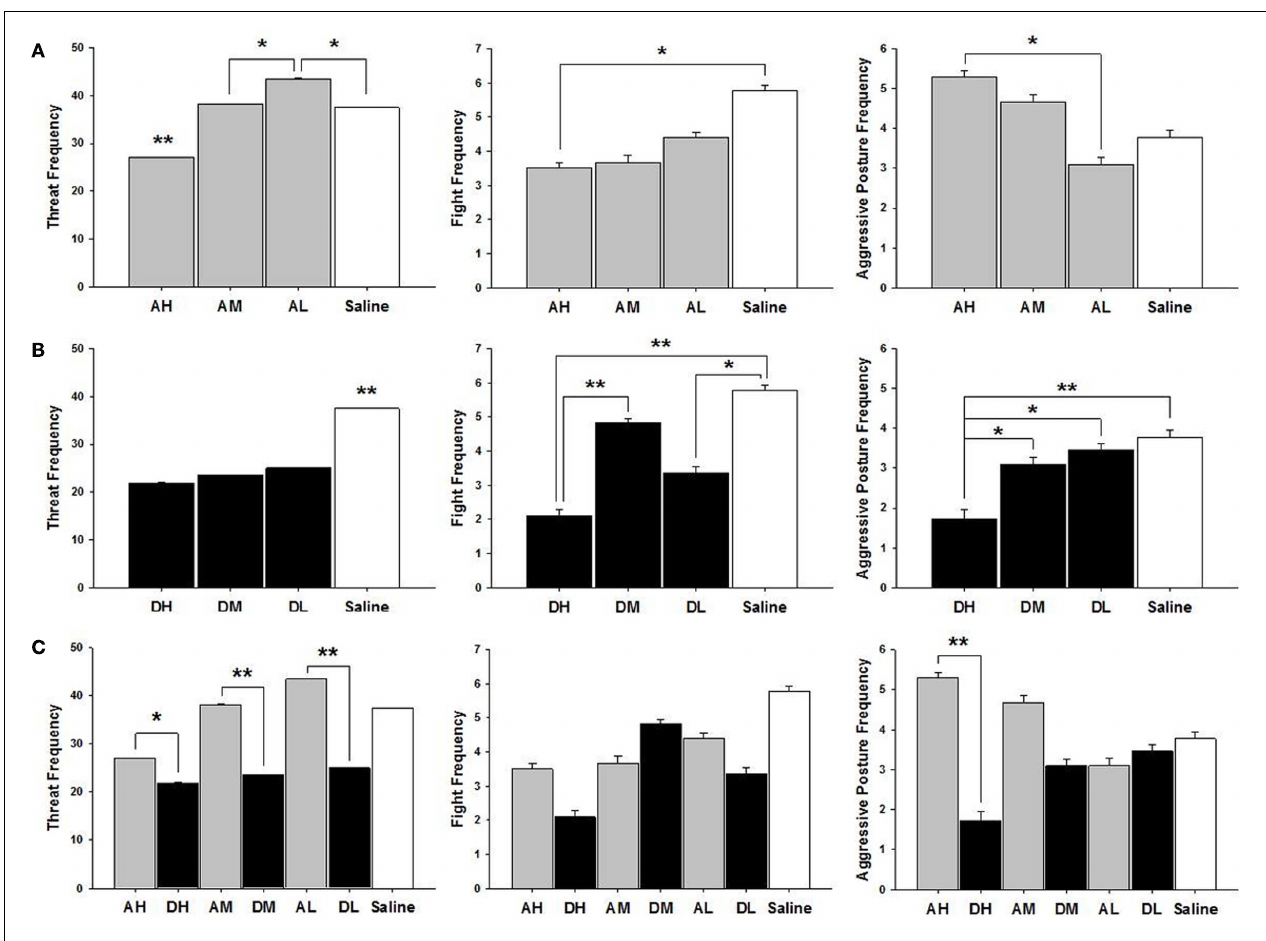
desipramine groups in black [DH, desipramine high (5mg/kg); DM, desipramine medium (5mg/kg); DL, desipramine low (1.25mg/kg)]) and saline control group in white [Saline = normal saline (2ml/kg)]. Comparisons between amitriptyline and desipramine groups were only tested between the high, medium, or low dose groups for each respective drug treatment group. All significant AH–DH, AM–DM, and AL–DL comparisons are denoted * p ≤ 0.05; ** p ≤